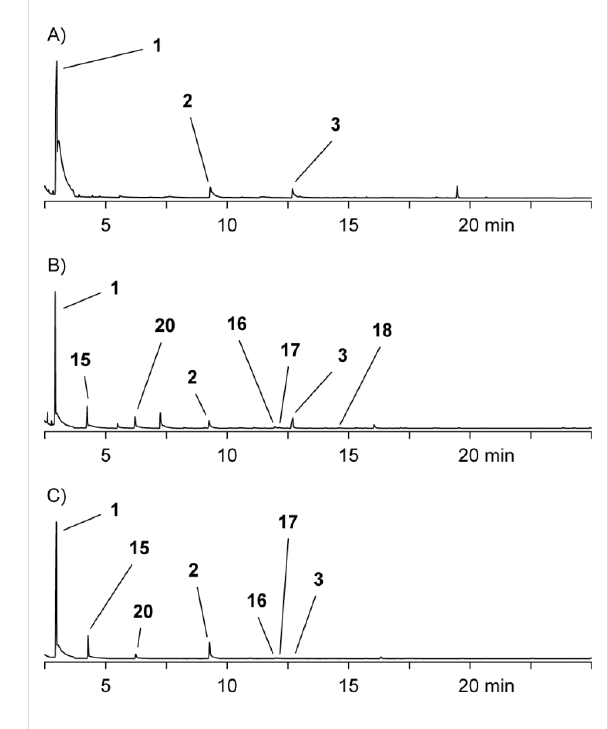
Figure 6: Volatiles from P. gallaeciensis after feeding of selenate and selenite. mutant strains compared to the wild type, indicating that as yet unidentified enzymes are responsible for the selenate/selenite reduction in P. gallaeciensis . These respective genes are not located on the 262 kb plasmid pPGA1_262, as the plasmid- cured mutant strain [27] was still able to produce methylated selenium volatiles from selenate and selenite.